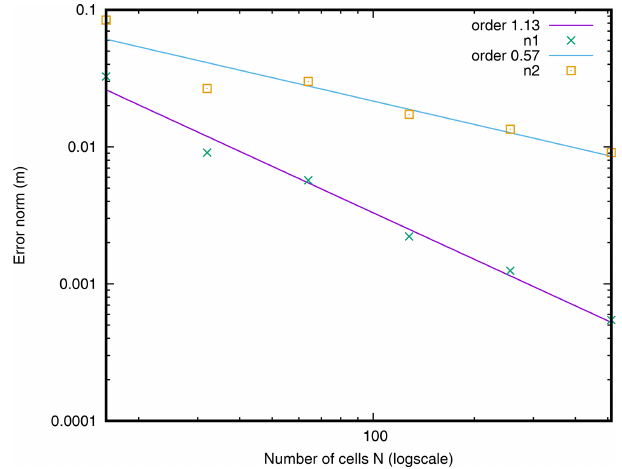
Figure 6. Convergence of the different error norms when the reso- lution is